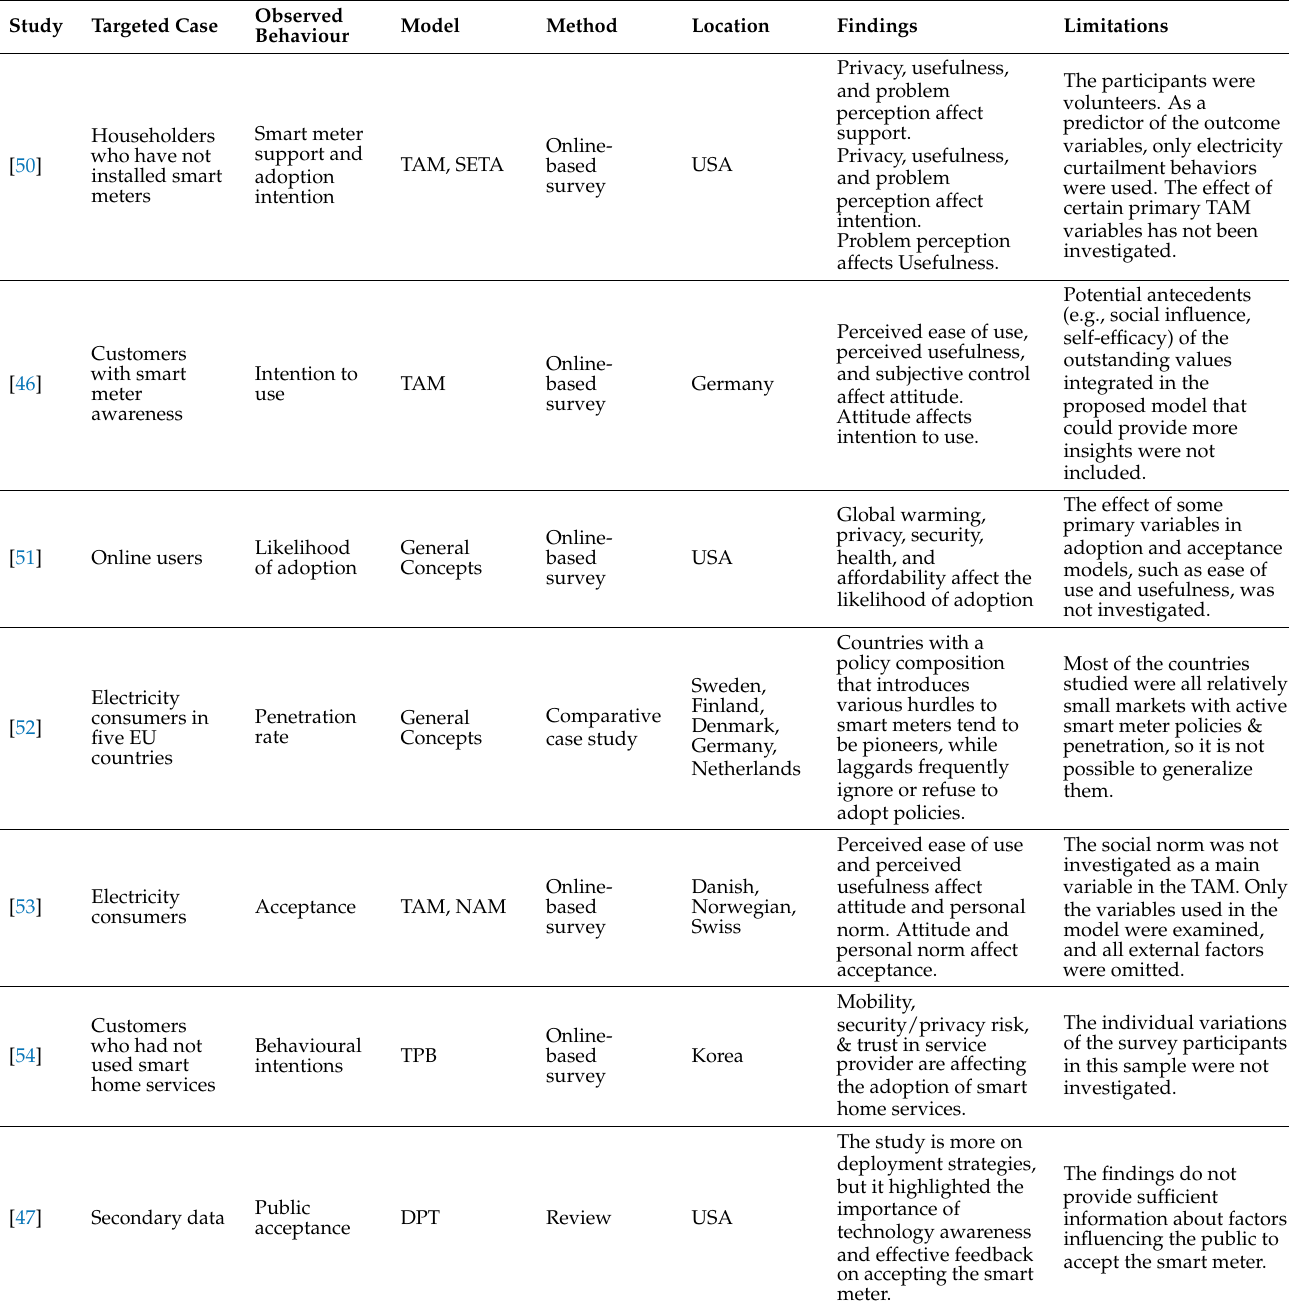
Table 2. Related studies on smart meter